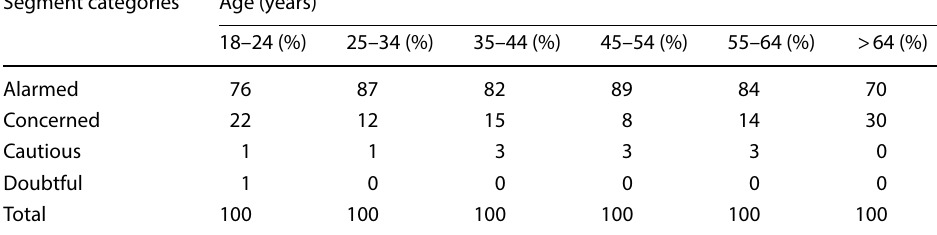
Table 7 Segments audience participation by